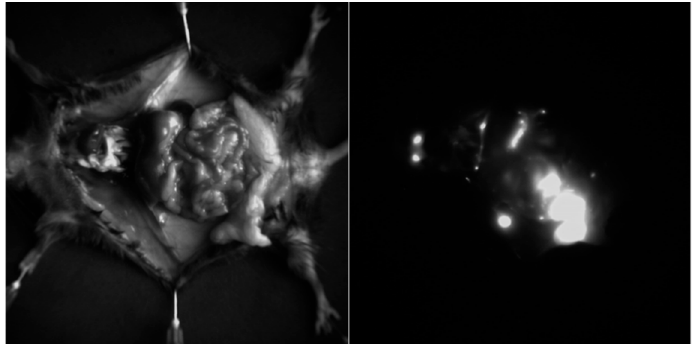
Figure 14. Bright-field image of the mouse organocomplex ( left ) and epiluminescent image of the mouse organocomplex marked with NaYF 4 :Yb,Tm -PLGA-nanocur ( right ), intravenous injection of 0.75 mg UCNPs, 4 h after injection.